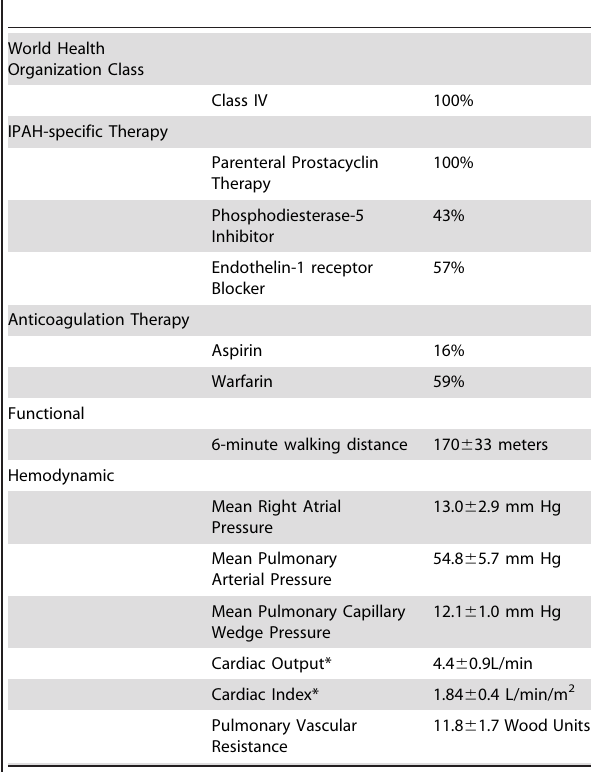
Table 2. Clinical, Functional and Hemodynamic Characteristics of IPAH Patients (N